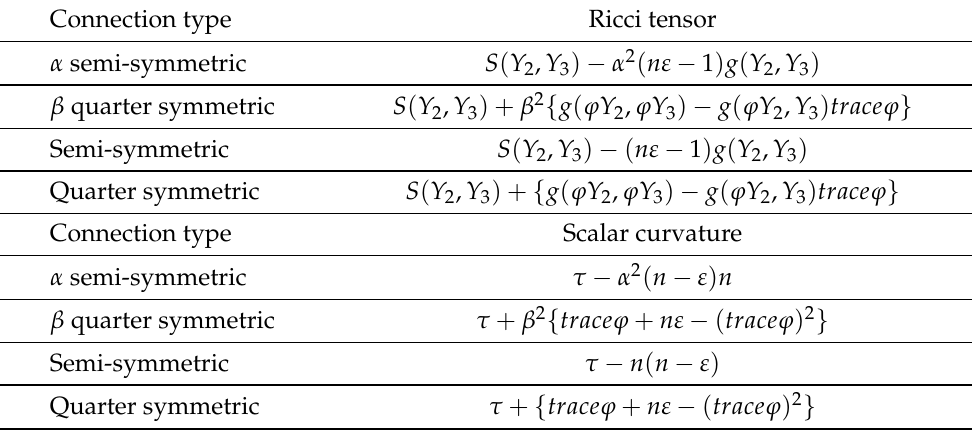
Table 1. Characterizations of any golden Lorentzian manifold equipped with generalized symmetric metric U -connection.